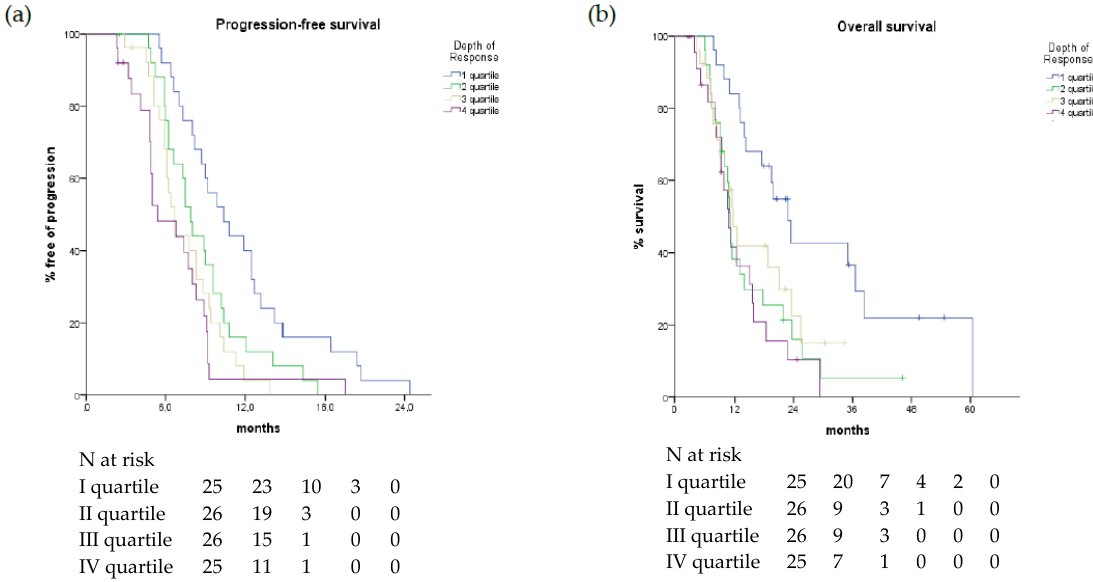
Figure 3. Progression-free Survival ( a ) and Overall Survival ( b ) curves according to DoR quartiles in overall population.